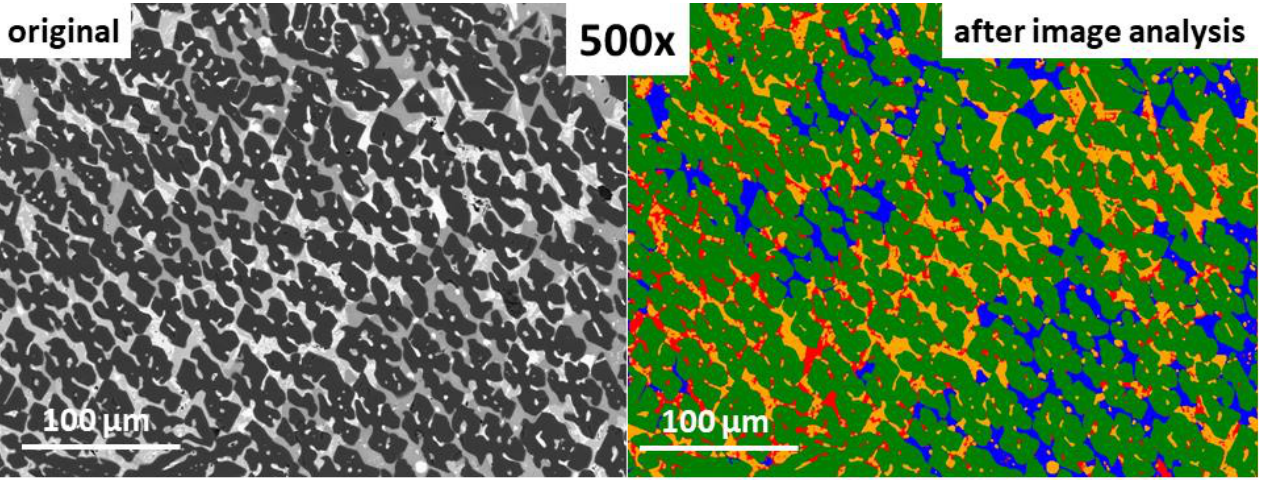
Figure 17. 500× magnified original SEM image ( left ), and image the after analysis using the developed algorithm ( right ).